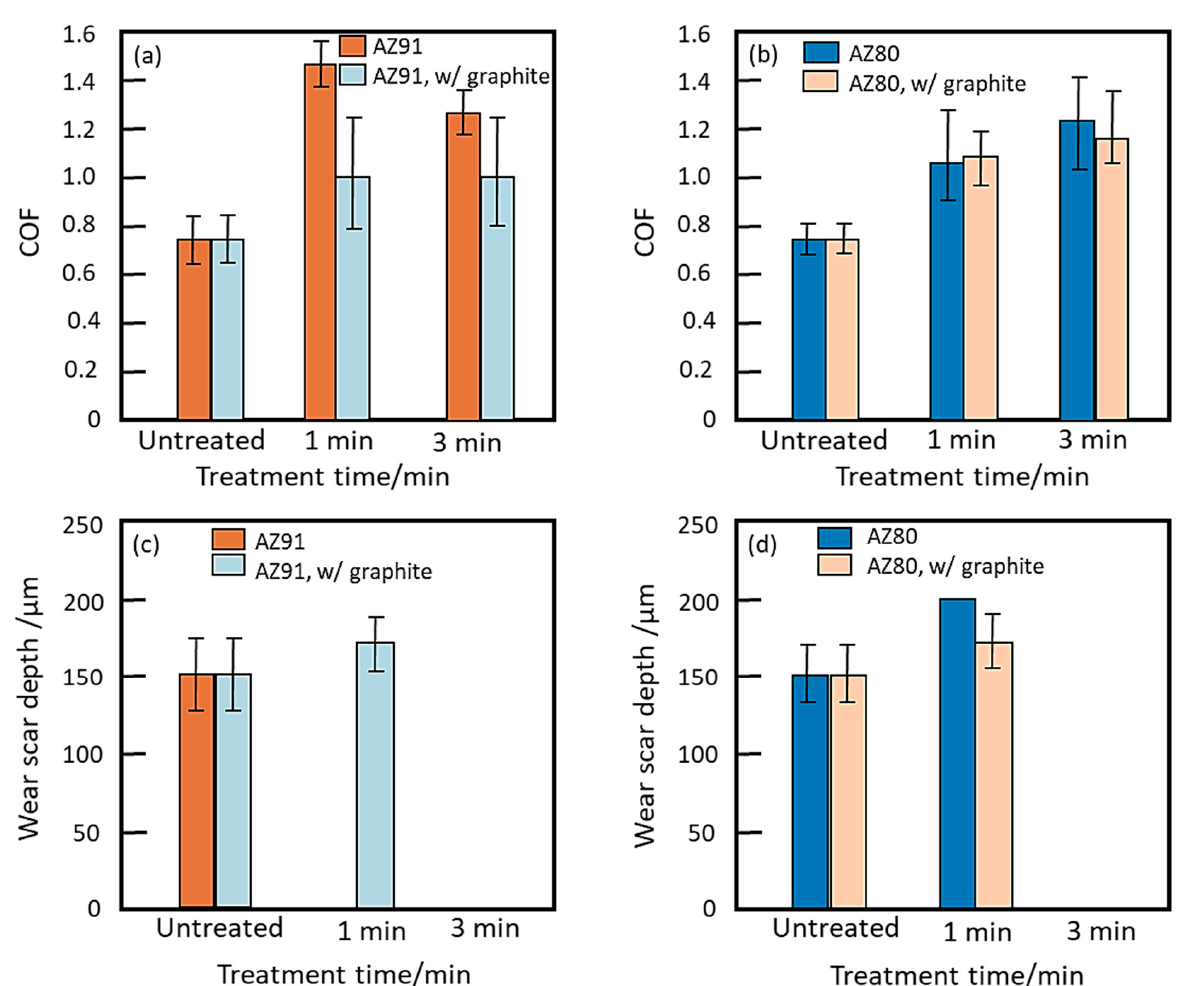
Figure 23. Bar charts comparing ( a ) COF for AZ91 with and without graphite, ( b ) COF for AZ80 with and without graphite, ( c ) wear scar depth of AZ91 with and without graphite, and ( d ) wear scar depth for AZ80 with and without graphite. Adapted from [175]. Copyright Elsevier, 2018.